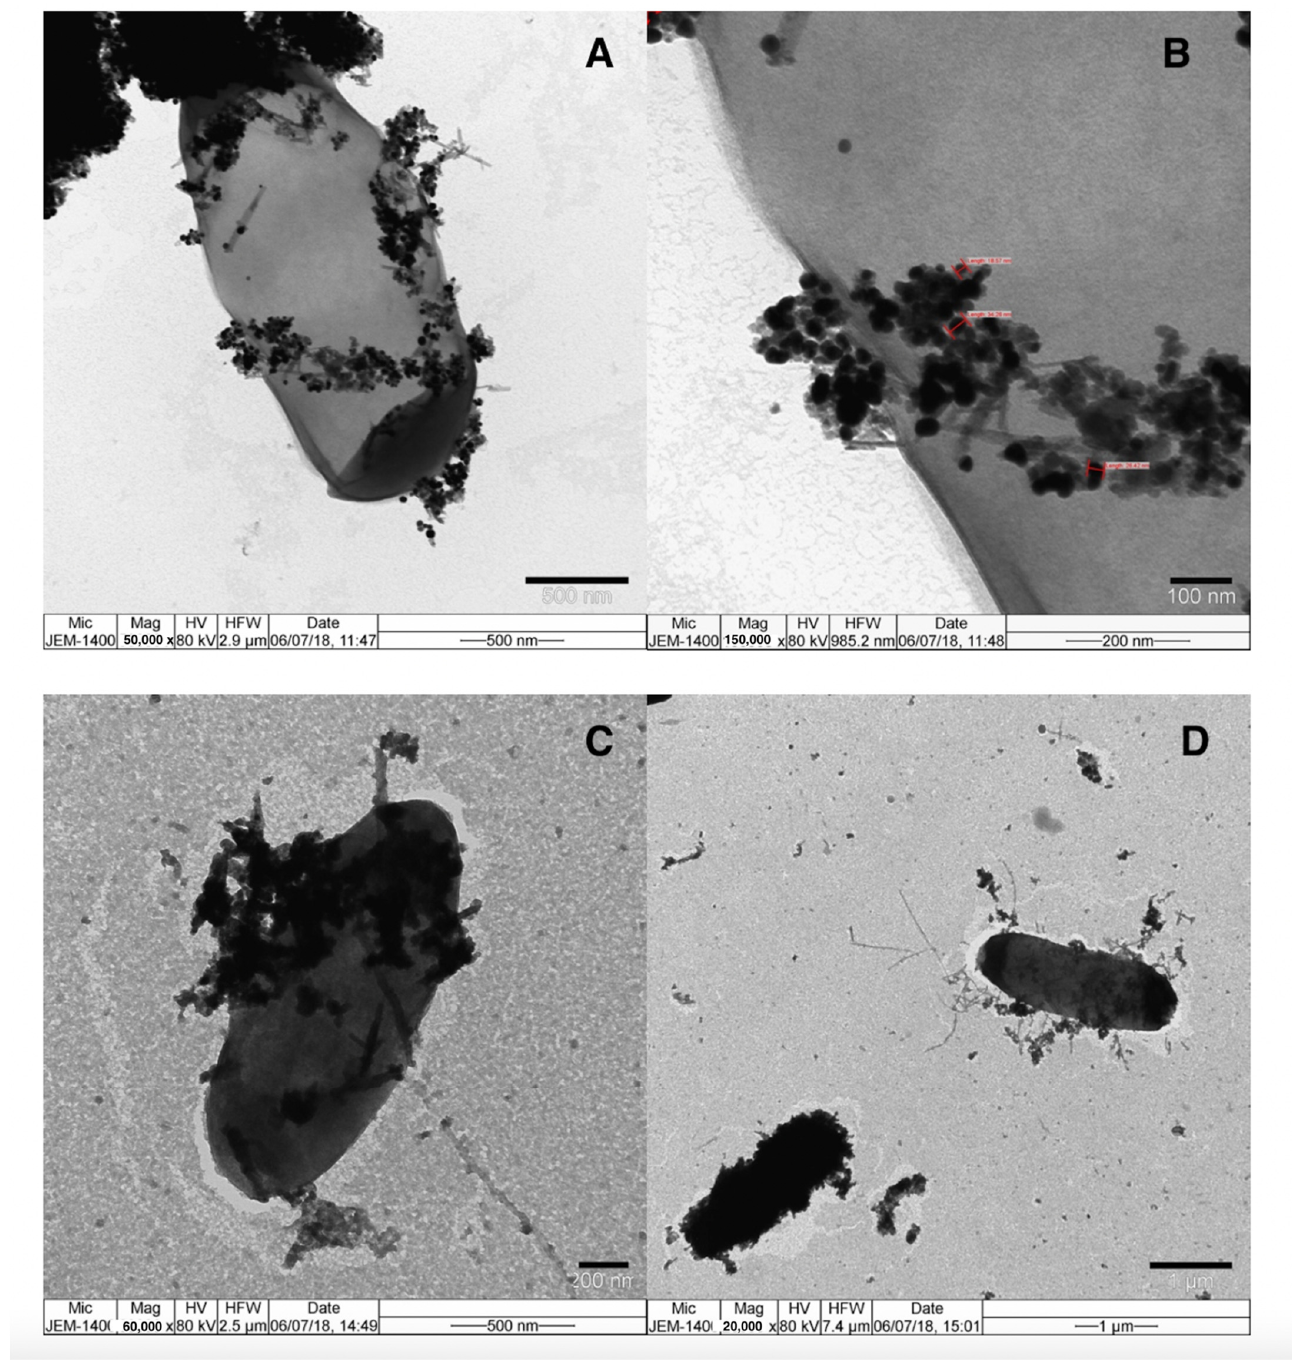
Figure 3. TEM images of E. coli interactions with modified MNPs ( A , B ) and MNPs with Au NRs ( C , D ).